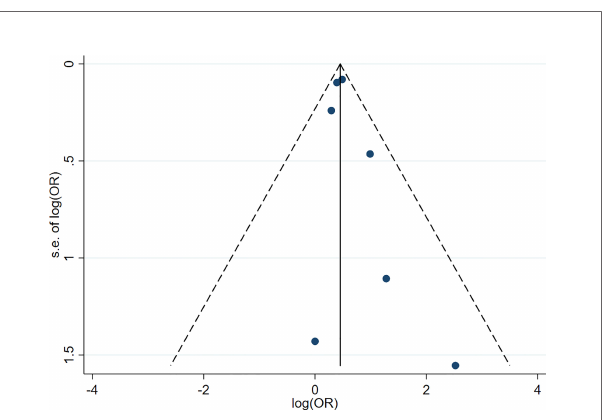
FIGURE 4 | Funnel plot of the meta-analysis of risk of Parkinson ’ s disease in patients with hypothyroidism.